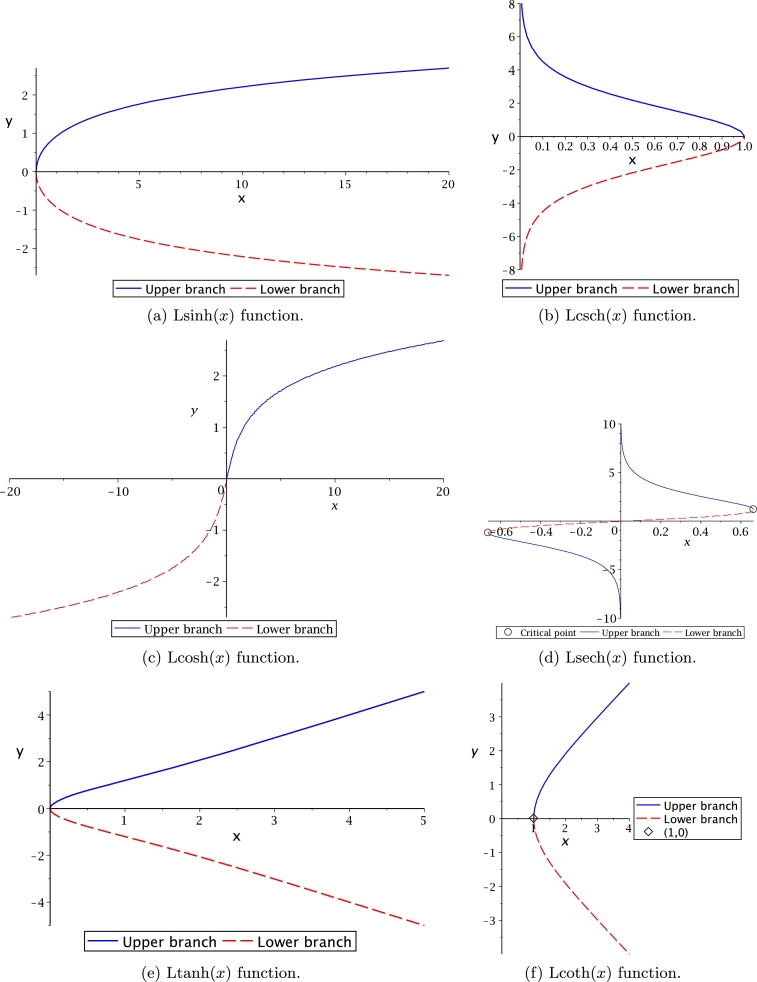
Hyperbolic Leal-functions.